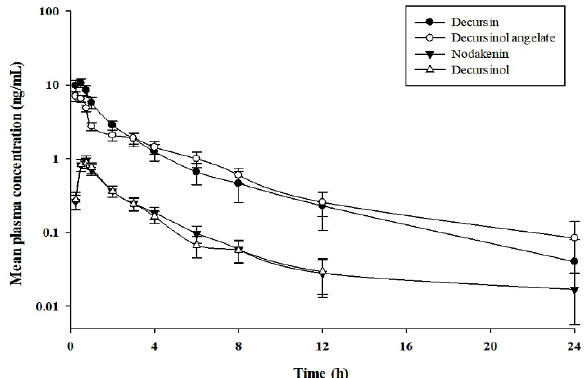
Figure 4. Mean plasma concentration–time profiles of four coumarins after oral administration of AGN root extract powder (4.6 g) in humans (Mean ± SE, n = 10).